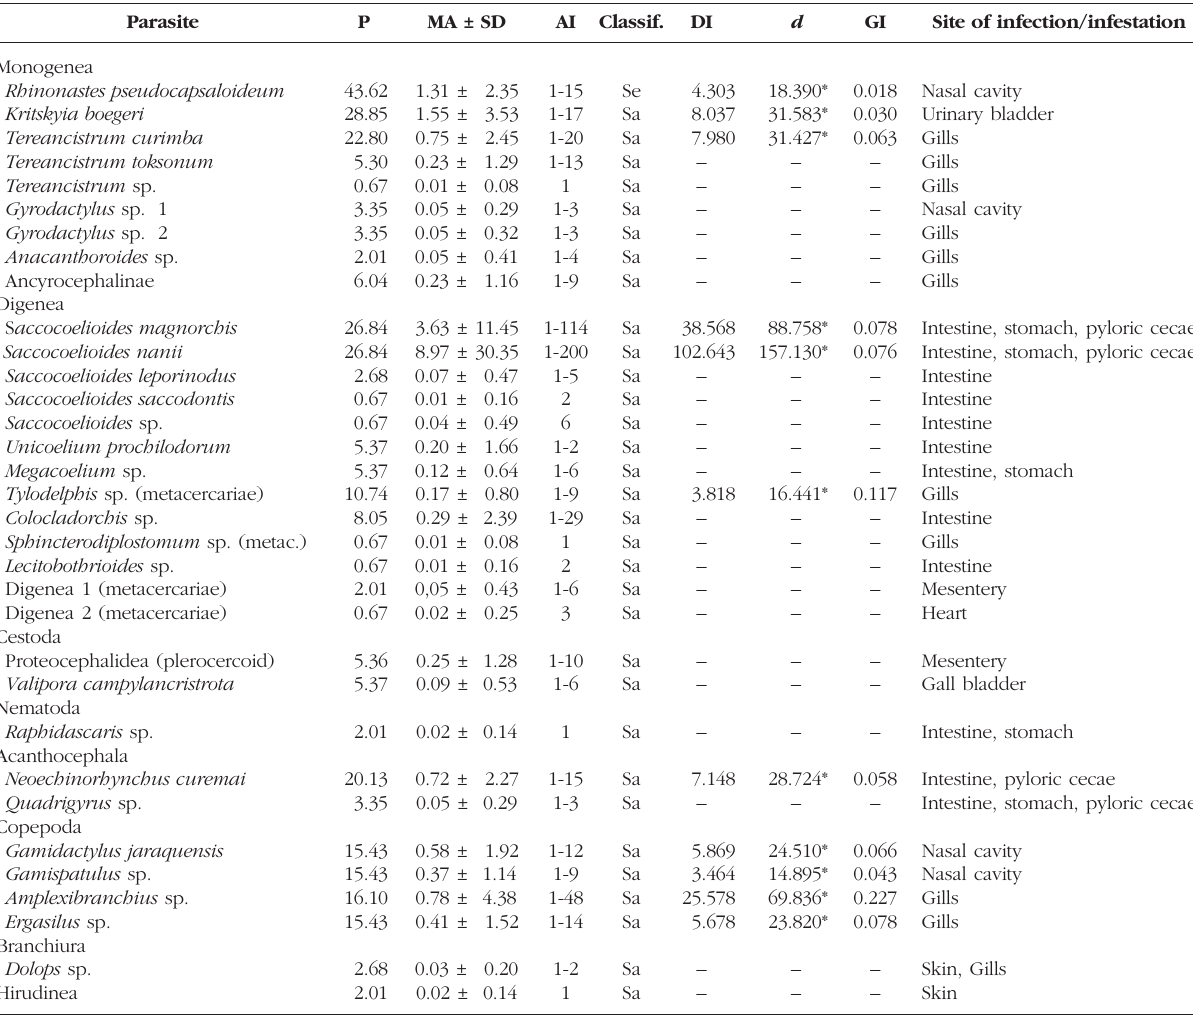
Table I. – Prevalence values (P%), Mean abundance (MA), Amplitude of intensity (AI), Classification according to the importance for the community (Hanski, 1982; Bush & Holmes, 1986) (Central (Ce), Secondary (Se) and Satellite species (Sa)), Dispersion index values (DI), the statistic d , the Green index of aggregation (GI) and the site of infection/infestation of the parasite fauna of Prochilodus lineatus , cap- tured on the upper Paraná River floodplain from February 2000 to June